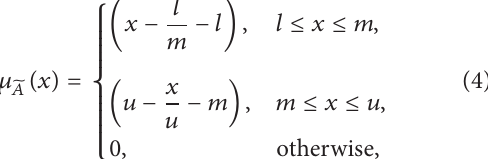
makers’ ambiguous and/or vague preferences. The logical way to overcome this limitation is to define the comparison ratios in terms of fuzzy